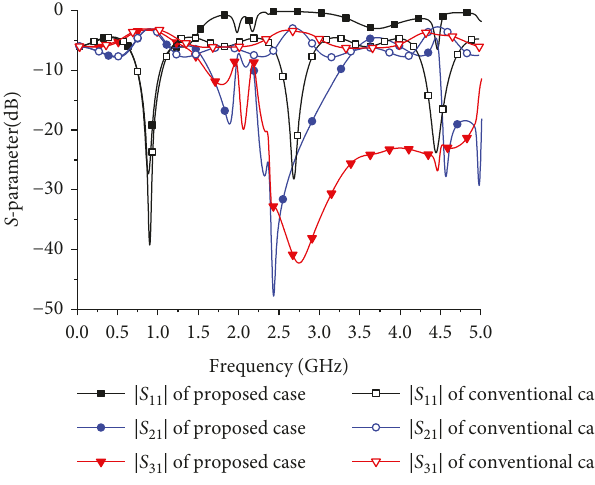
and phase di ff erence of the proposed branch-line coupler. 41